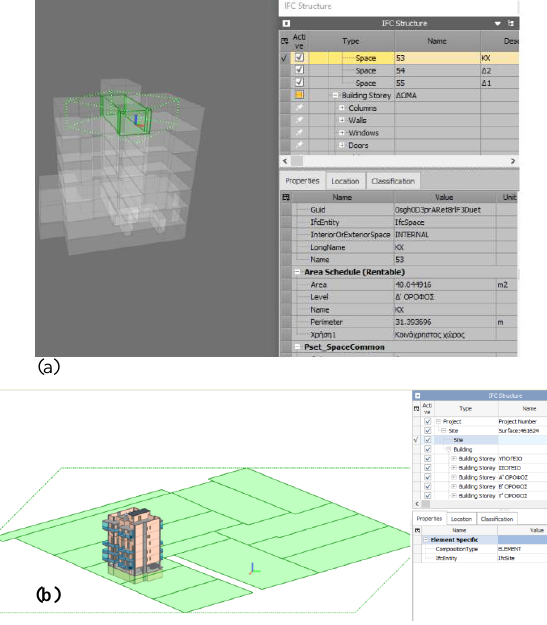
Figure 2. (a) 3D IfcSpace entity and (b) IFC model Source: View of IFC model in BIM Vision free software